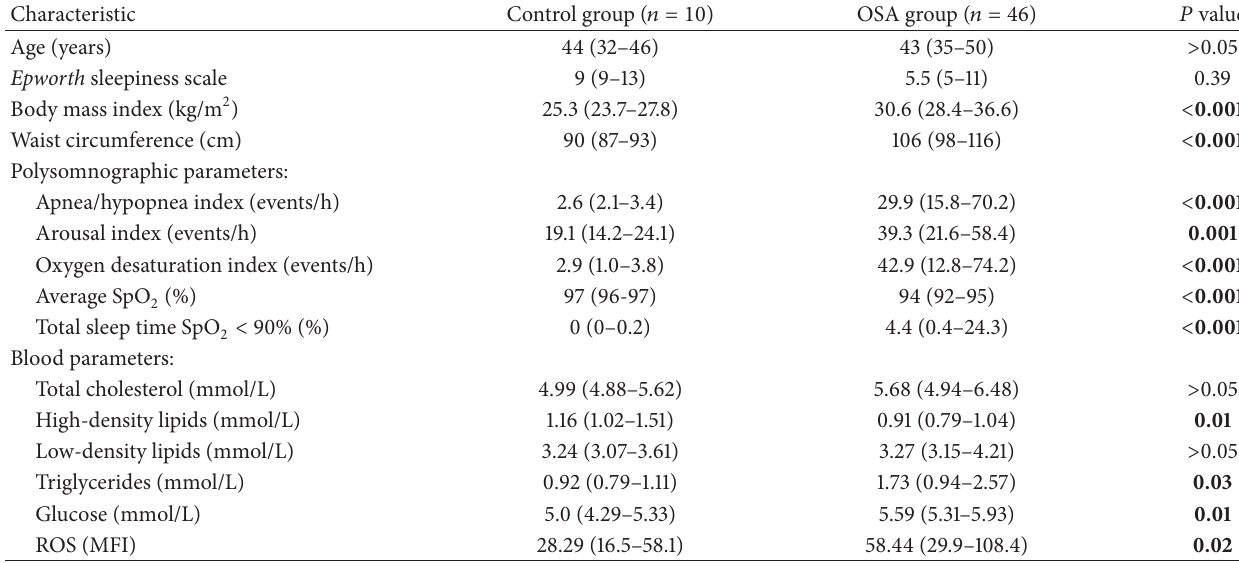
Table 1: Characteristics of the controls and the obstructive sleep apnea patients.